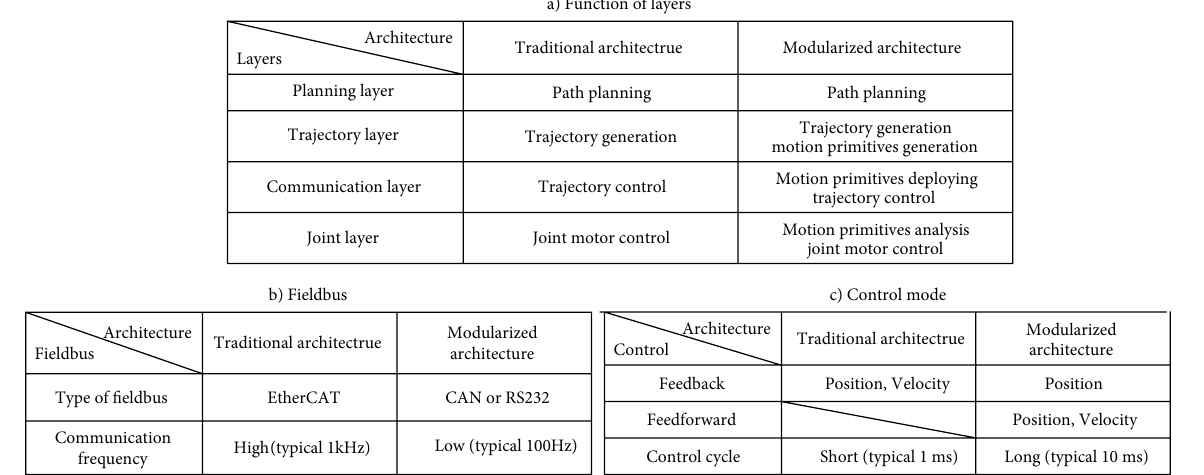
Figure 5: Centralized structure vs modularized